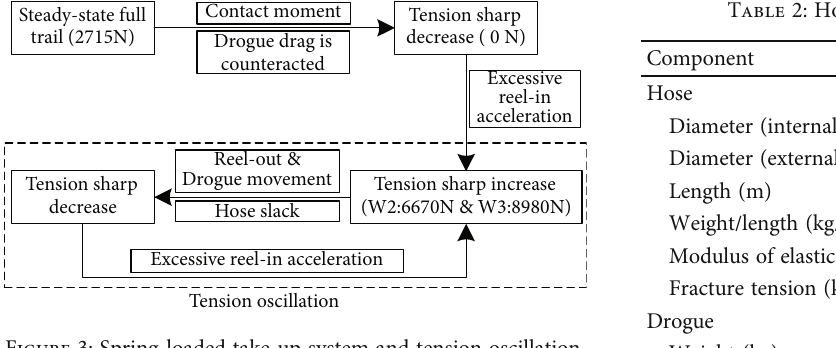
Figure 3: Spring-loaded take-up system and tension oscillation.